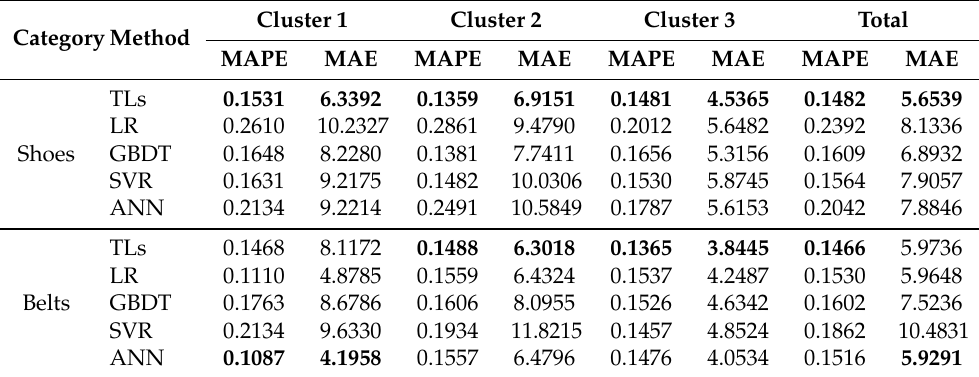
Table 5. Forecasting performance of the five forecasters and one benchmark over two categories in the test